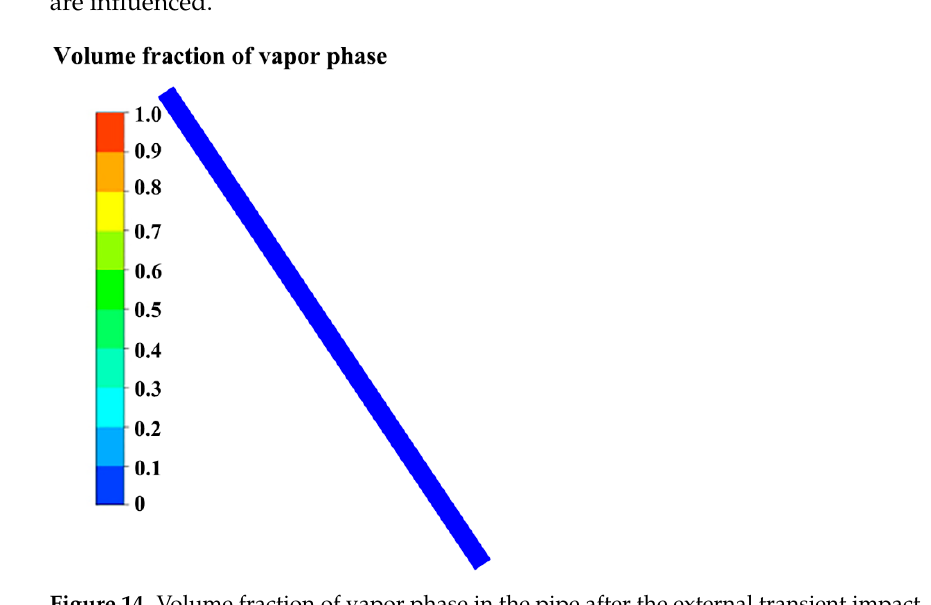
Figure 14. Volume fraction of vapor phase in the pipe after the external transient